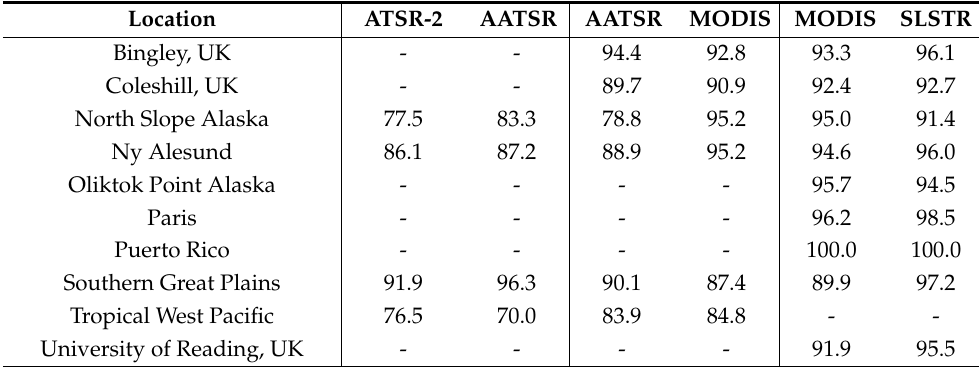
Table 7. Bayesian cloud detection hit rate percentage with reference to ceilometer observations for overlapping data between different sensors: ATSR-2 and AATSR, AATSR and MODIS, MODIS and